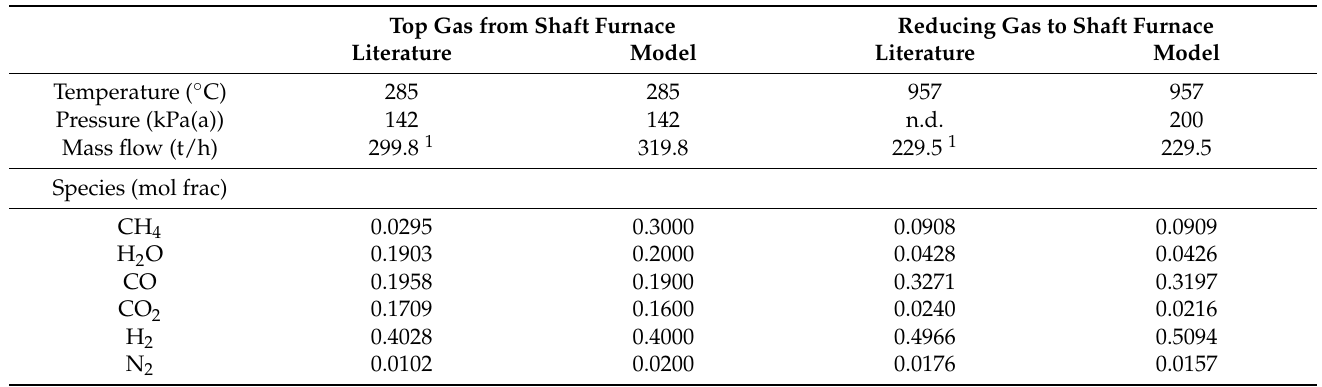
Table 4. Comparison of Base—M model boundaries at shaft furnace to